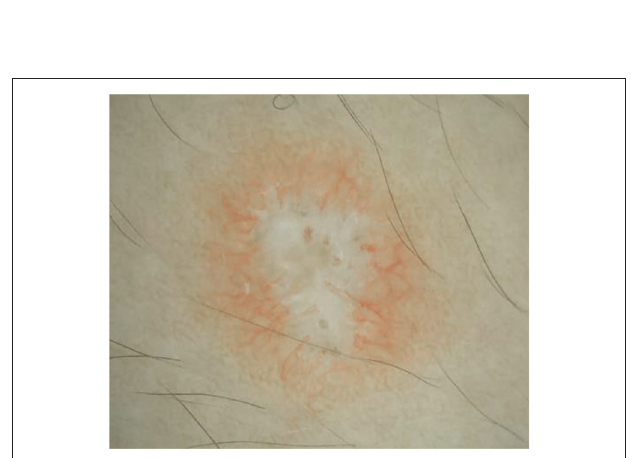
FIGURE 4 | Dermoscopy showed central porcelain-white structureless area crowded by hairpin